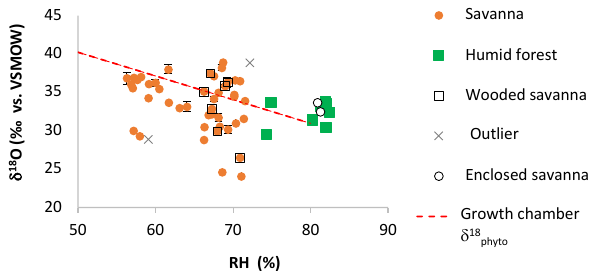
Figure 3. Natural West and Central African transect: δ (cid:48) 18 O of phy- toliths ( δ (cid:48) 18 O Phyto ) vs. relative humidity RH-rd0>1 (see Fig. 4 for explanation). Error bars show standard deviation (SD) on the repli- cates. When not shown, they are smaller than the symbol.